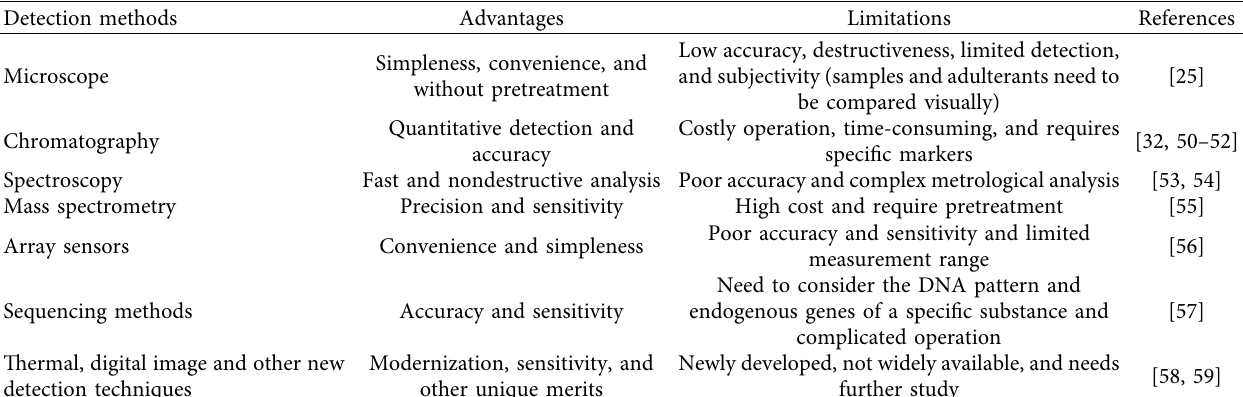
Figure 2: Te typical workfow of targeted and nontargeted approaches. Table 1: Advantages and limitations of diferent detection methods in cofee quality. Detection